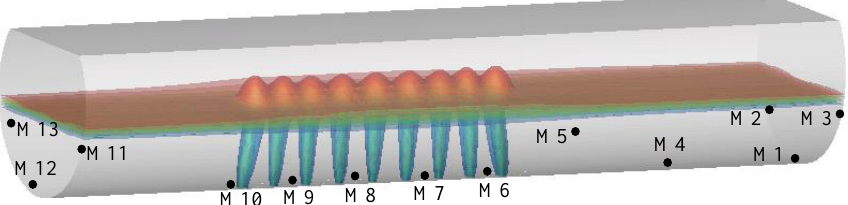
Figure 3. Arrangement of tracer monitoring points (M1 to M13) in a bath.